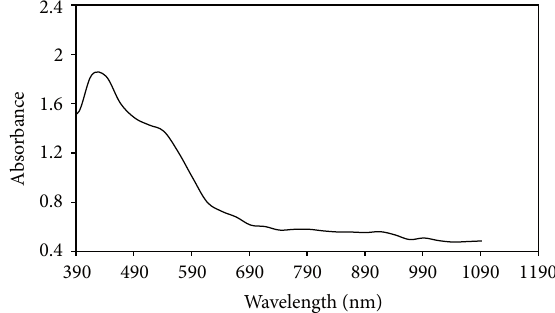
F 7: UV spectrum showing the formation of product at 432nm in high catalyst concentration aer the decomposition of intermediate complex at